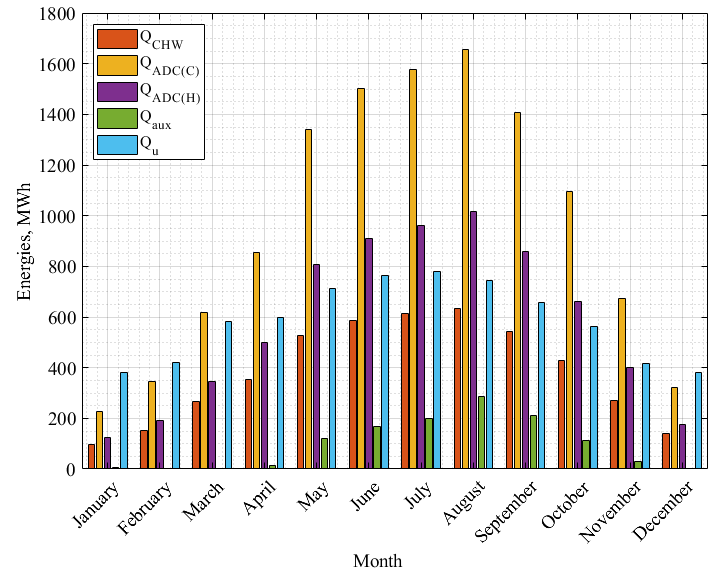
Figure 14. Monthly distribution of energies of the ADC